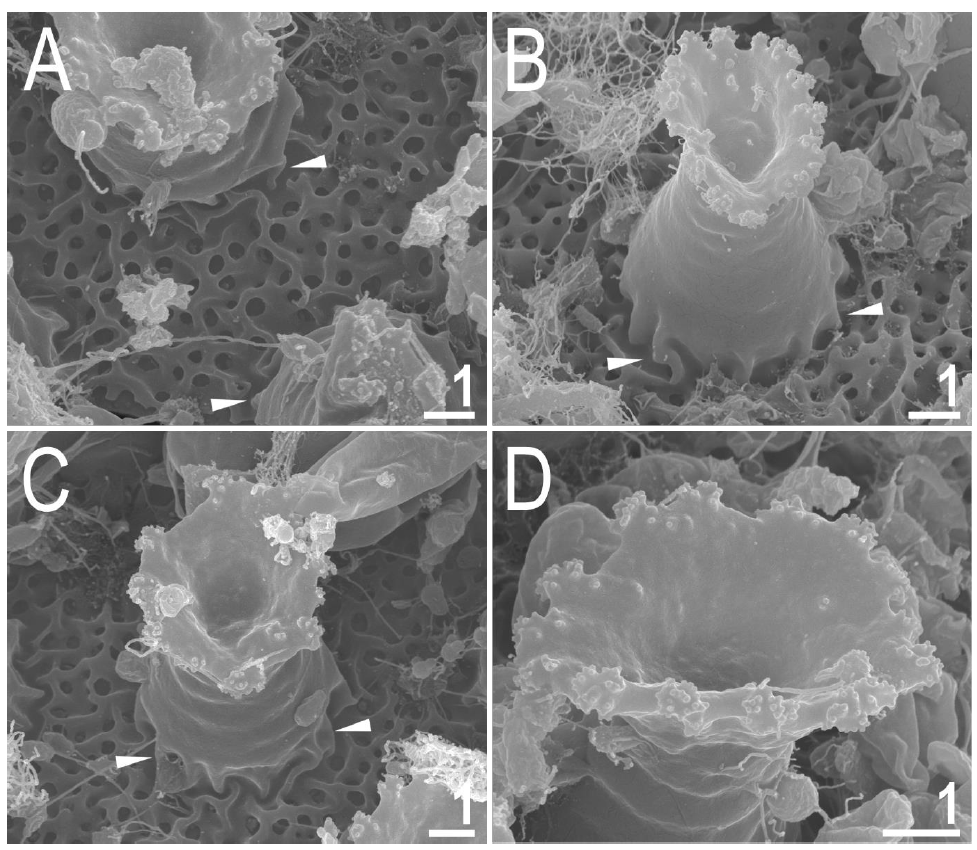
Figure 8. Macrobiotus rebecchii sp. nov. SEM images of eggs: ( A – C ) details of egg processes and the surface between them; ( D ) details of the terminal disc. The filled flat arrowheads indicate thickenings around the processes bases. Scale bars in μm. Table 3. Measurements ( in μm ) of the eggs of Macrobiotus rebecchii sp. nov.; eggs mounted in Hoyer’s medium; process base/height ratio is expressed as percentage; N — number of eggs/structures meas- ured. Range refers to the smallest and the largest structure among all measured specimens; SD — standard deviation.